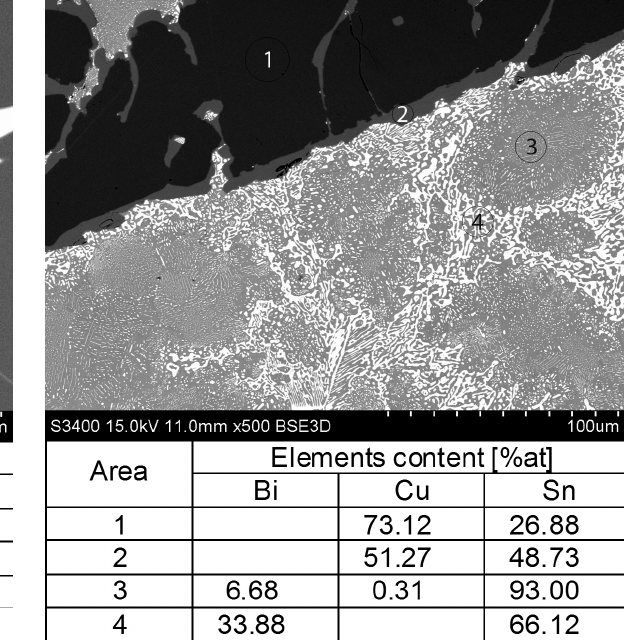
Figure 10: Microstructure of the alloy no 3.